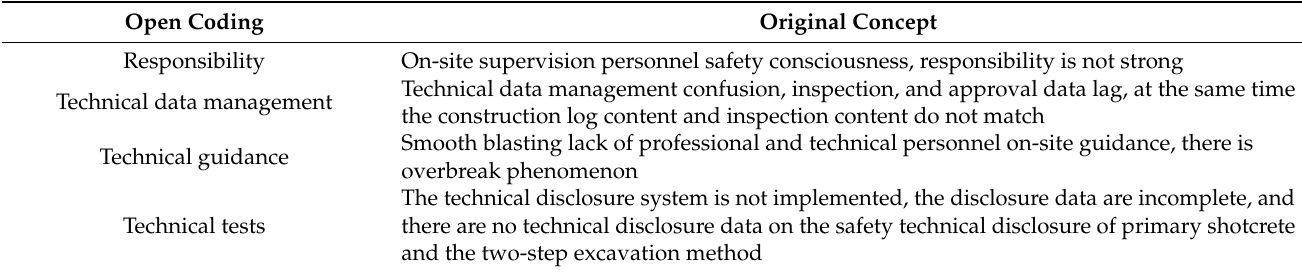
Table 3. Open coding example (excerpt).